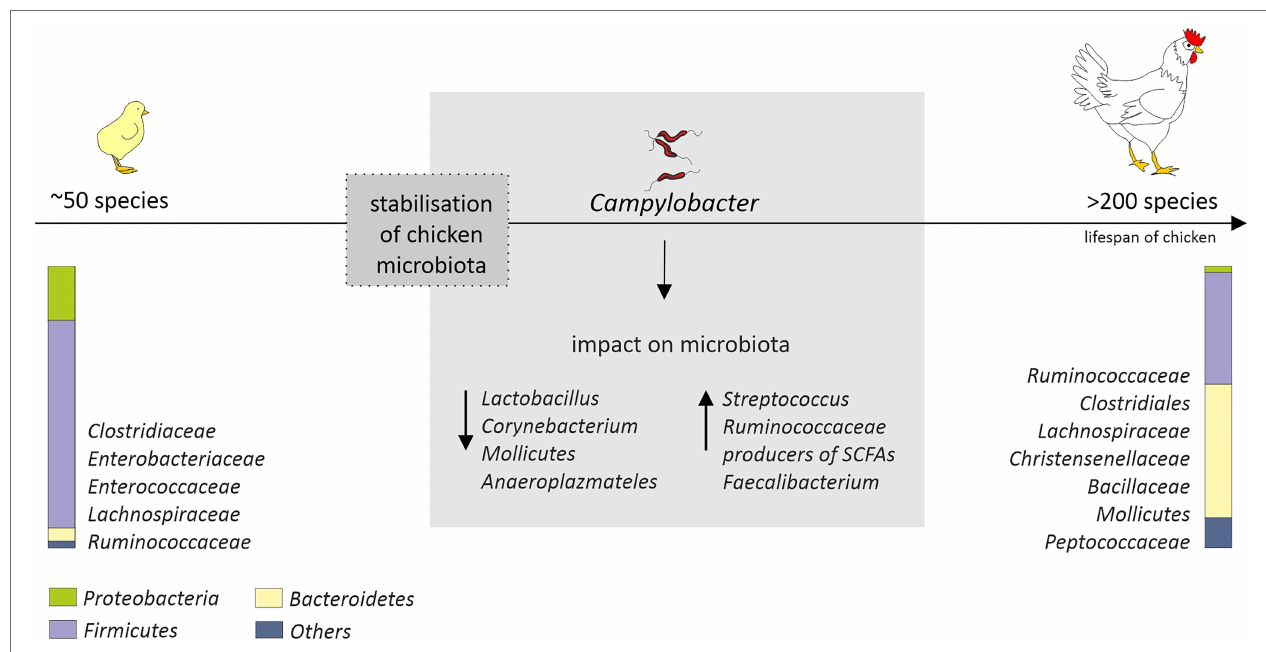
FIGURE 1 | Age-related changes in the chicken cecal microbiota (from hatch to 42 days of age) and potential impact of Campylobacter jejuni colonization that could affect microbiota composition. After hatch, the microbiota is mainly composed of environmental bacteria. Stabilization of the microbial diversity occurs after 10–20 days post-hatch. The diagram is based on the information provided by (Oakley et al., 2014a; Thibodeau et al., 2015; Connerton et al., 2018; Richards et al., 2019; Duquenoy et al., 2020). The distribution of the most common and abundant bacterial taxa (phylum, order, and family) in the ceca of the chickens is